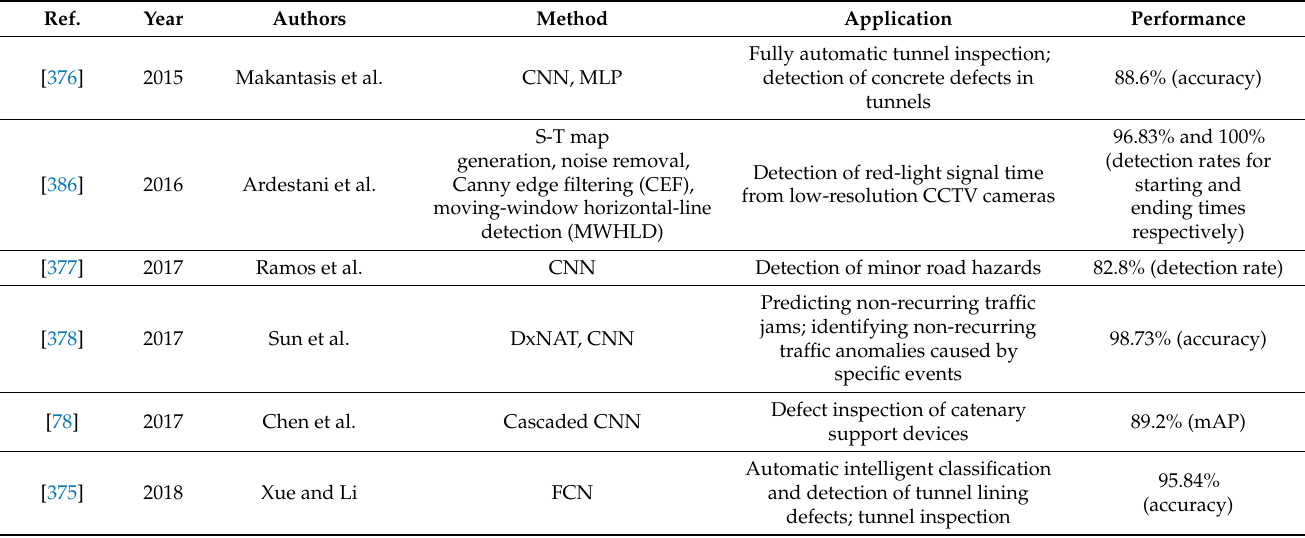
Table 12. Other ITS Applications Using CV